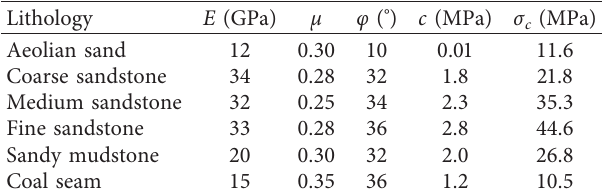
Table 1: Experimental intensity values of coal and rock samples. Lithology E (GPa) μ φ ( ° ) c (MPa) σ c (MPa) Aeolian